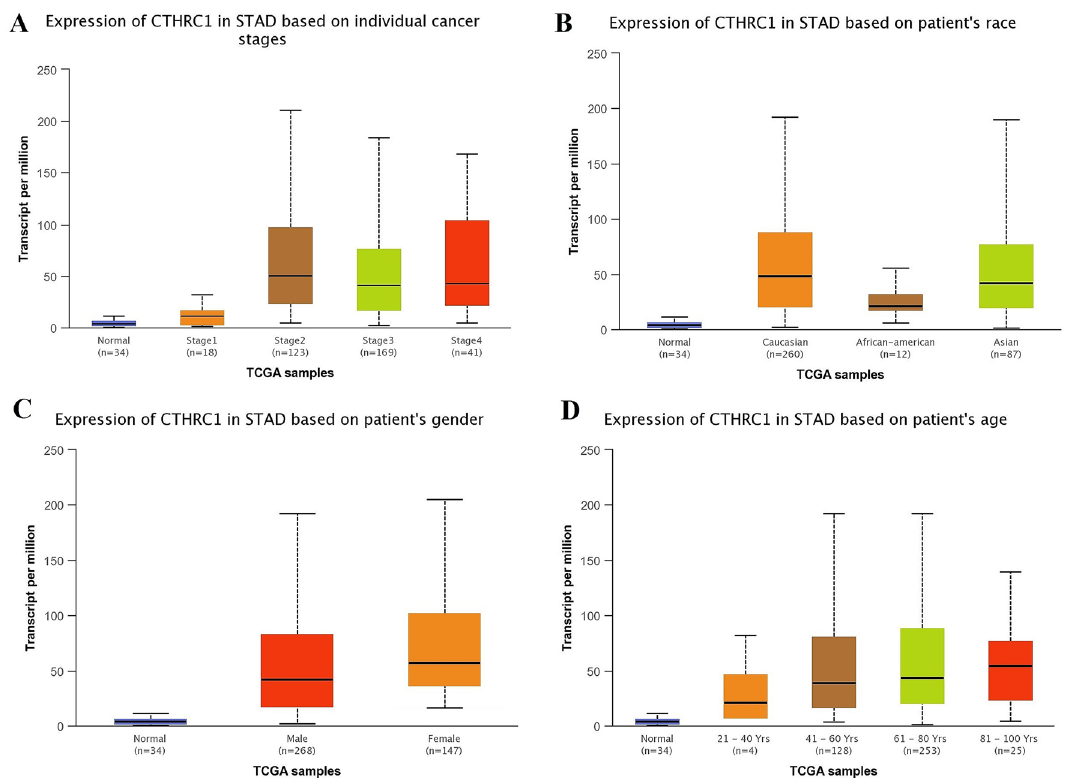
Figure 8. CTHRC1 transcription in various clinicopathological parameters of STAD. ( A ) Different cancer stages based, ( B ) Different patients race based, ( C ) Different patients gender based, and ( D ) Different age groups based. A p-value of < 0.05 was selected as a cutoff